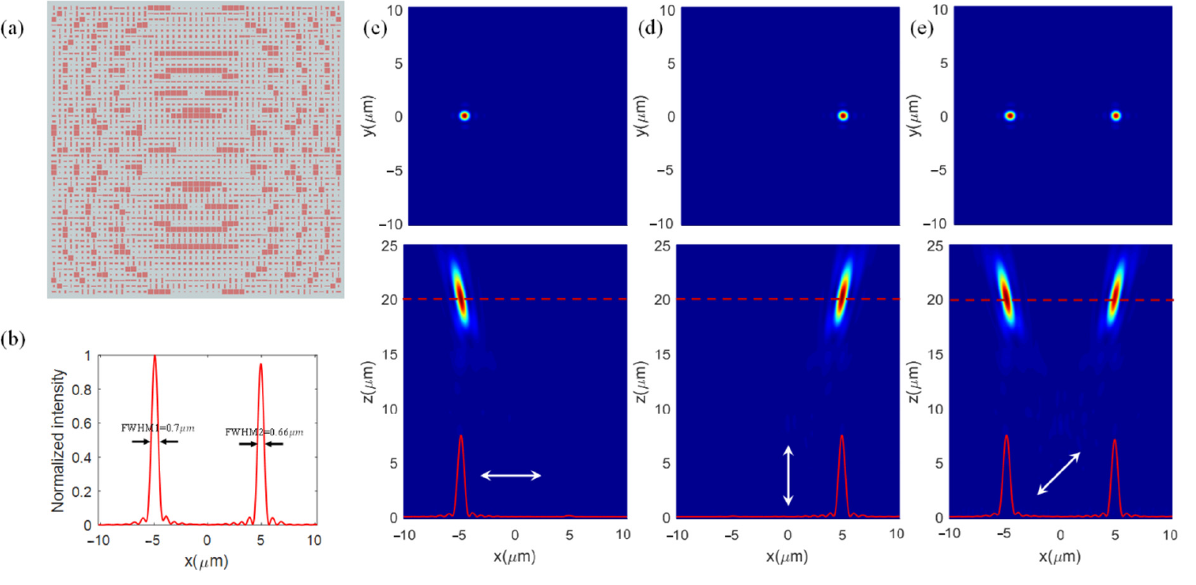
Figure 4. Simulation for the orthogonal linear polarization multiplexing metalens. ( a ) Top view of this designed metalens. ( b ) The sectional intensity profile along the x-axis in the focal plane. Inten- sity maps in the xy-plane and xz-plane under ( c ) x-, ( d ) y- and ( e ) 45°-linearly polarized light inci-